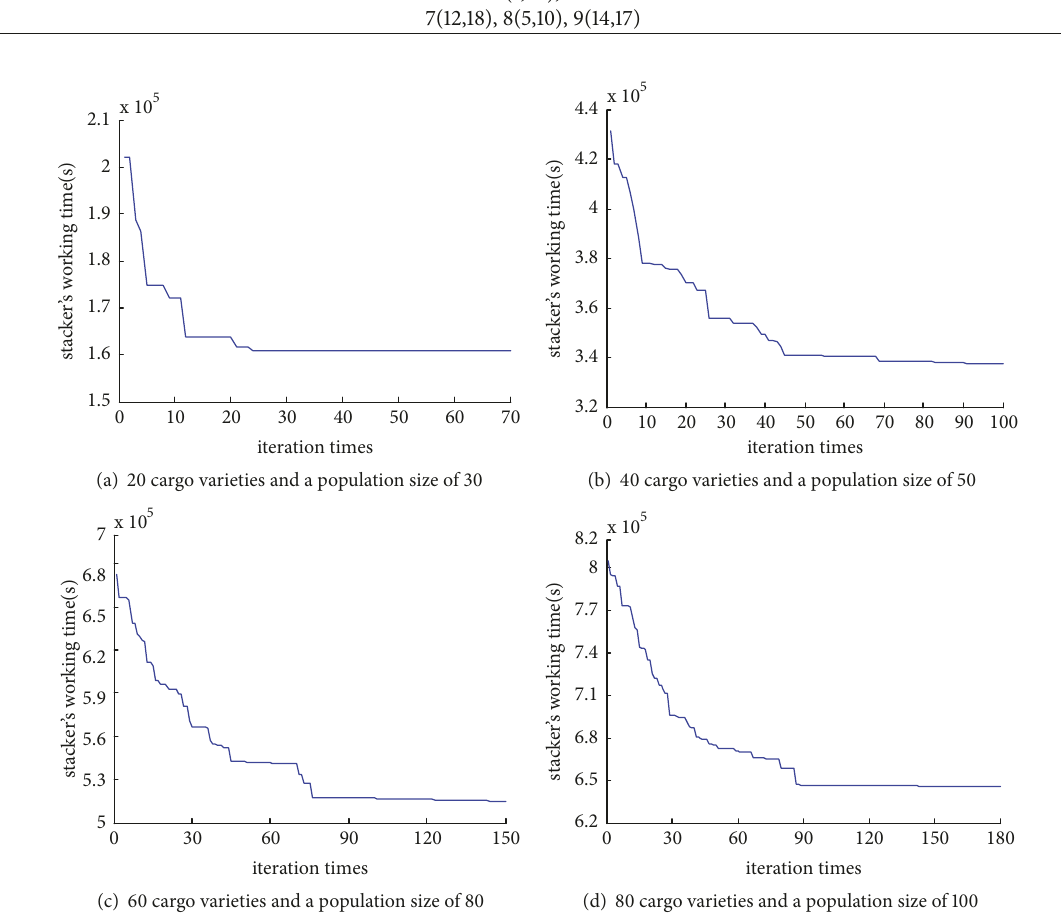
Figure 4: Algorithm convergence